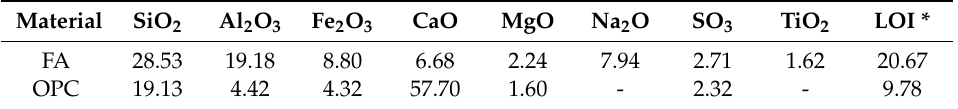
Table 4. Chemical composition of the materials used: fly ash (FA) and ordinary Portland cement (OPC).